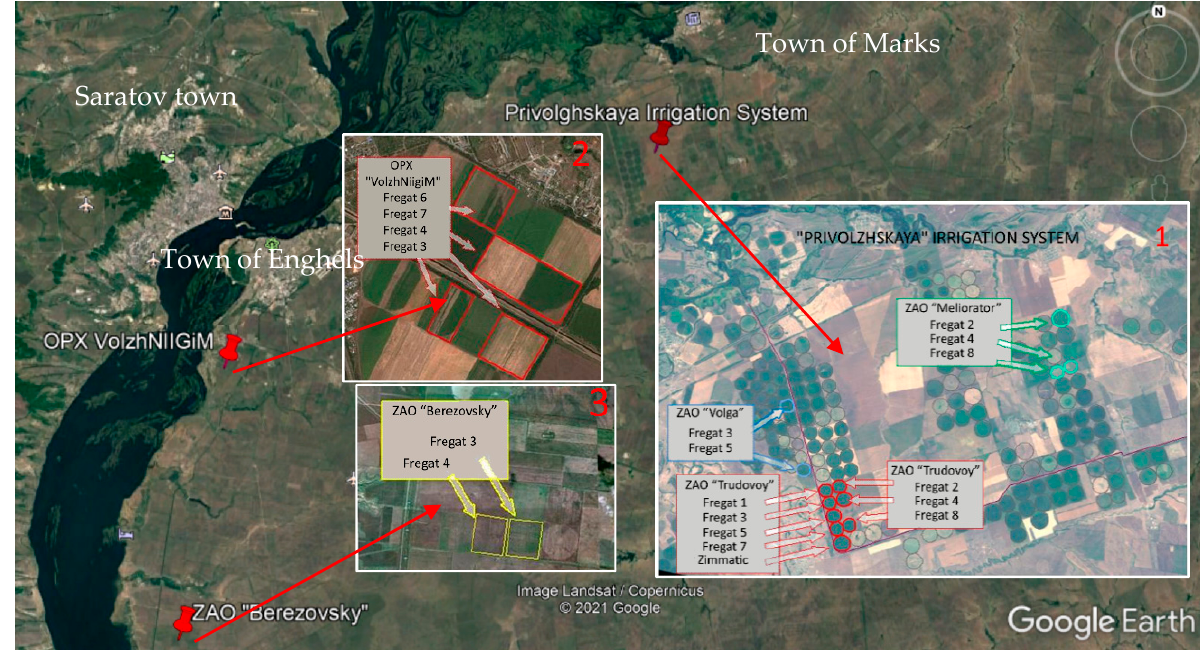
Figure 1. Three sites chosen in the reported study area with monitored crops: (1) at the territory of the Privolzhskaya Irrigation System belonging to the ZAO “Volga”; ZAO “Trudovoy”; ZAO “Meliorator”; (2) belonging to the VolzhNIIGiM; (3) belonging to the ZAO “Berezovsky” (source: Google Earth).